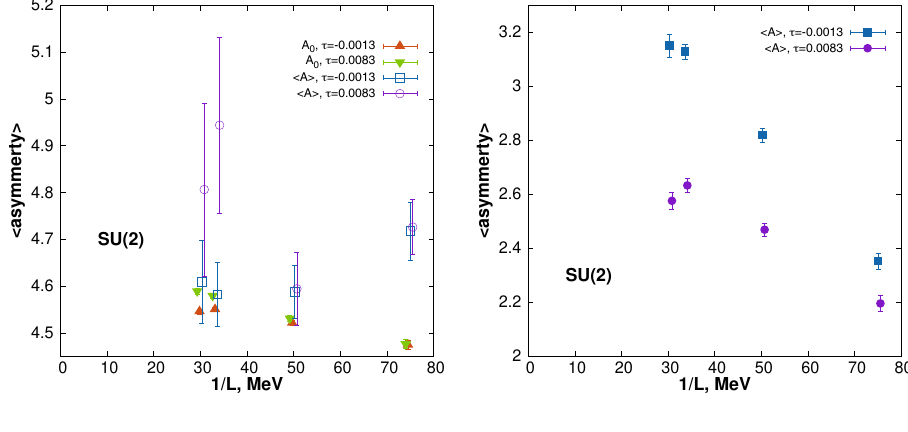
Figure 4: Finite-volume e ↵ ects for the asymmetry, both center sectors are taken into consideration. Right panel: results for the sector